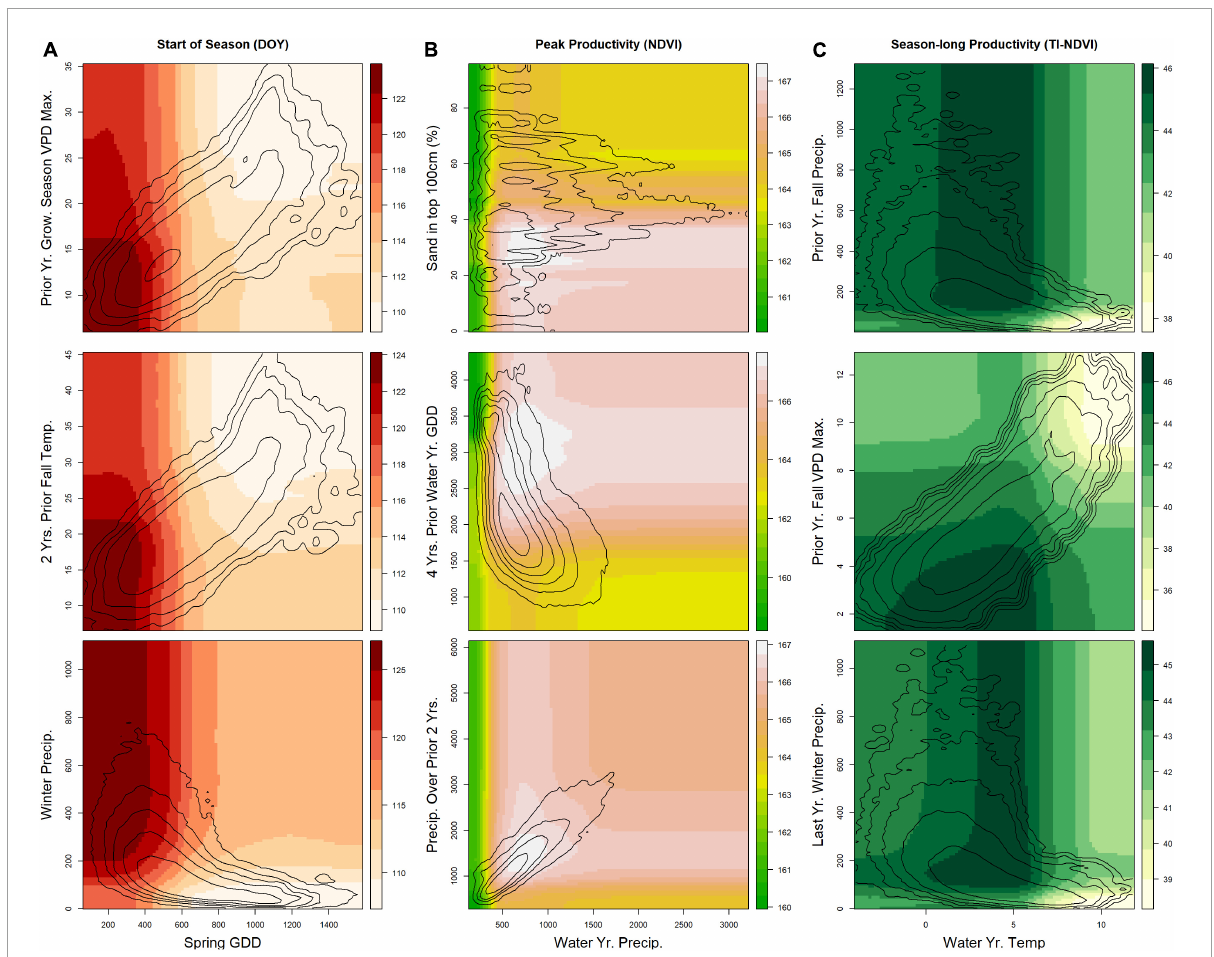
FIGURE6 Results from the final random forest models for areas of the U.S. Northwestern Plains having primarily evergreen forest land cover pixels. For each phenological measure, three partial-dependence plots show the relationship between selected pairs of variables. Contour lines show the natural logarithm of the kernel density (i.e., the distribution of the two variables in the dataset). Seasonal and yearly variables represent either (A) the mean over the time period for temperature ( ◦ C, Temp.) and vapor pressure deficit (hPa, VPD), (B) the cumulative sum for precipitation (mm, Precip.) or (C) exceedance of vapor pressure deficit (days over 1 or 2 times the SD of the long-term distribution) and growing degree-days ( ◦ C, GDD). Max, Maximum; SD, standard